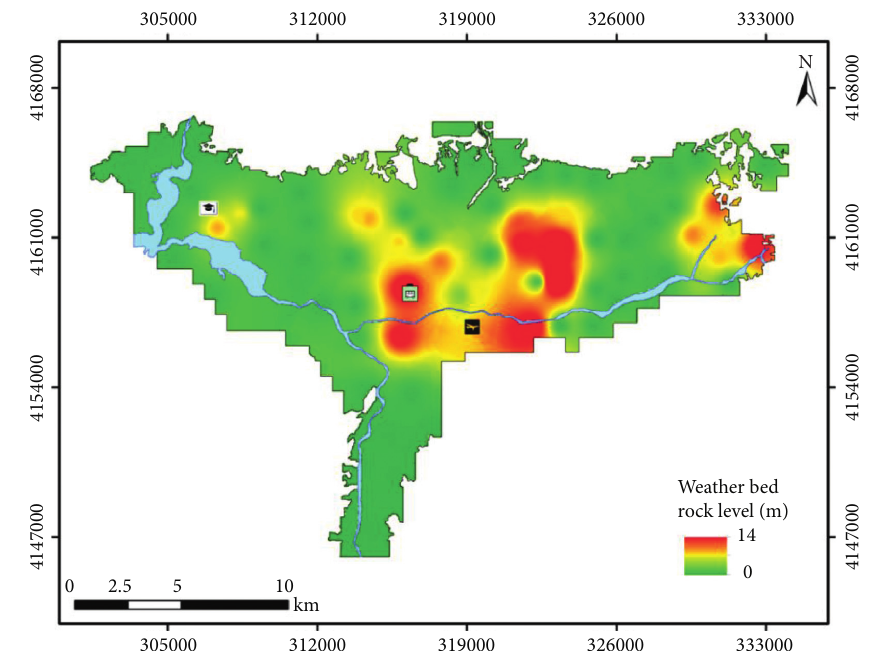
Figure 10: Weathered rock level in Kahramanmaras area using the MASW and MAM data.